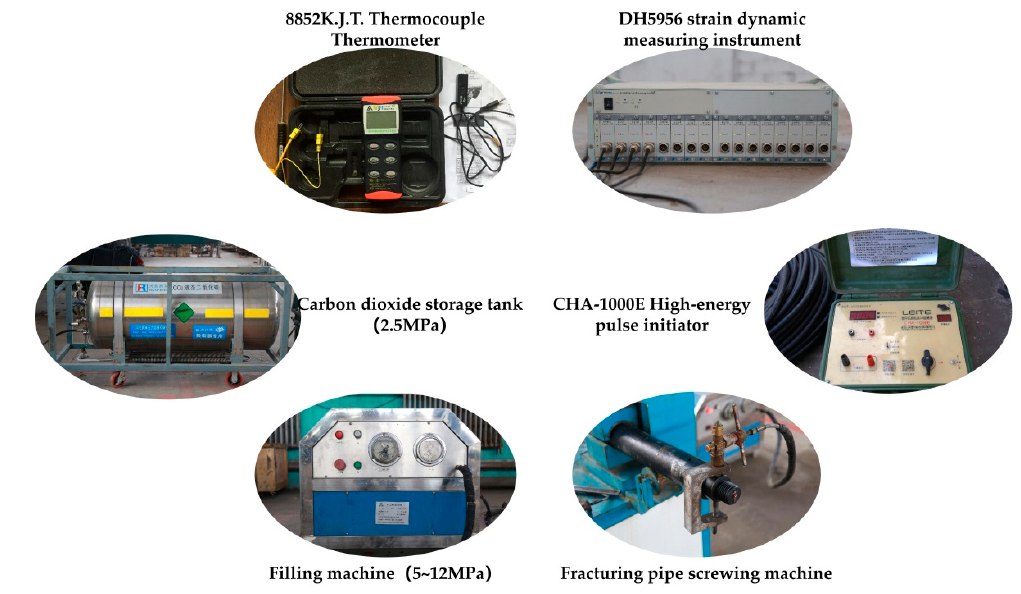
Figure 2. Carbon dioxide blasting experiment system.